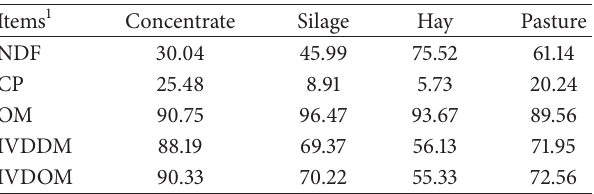
Table 1: Chemical composition of the experimental feeds (values are expressed as % of